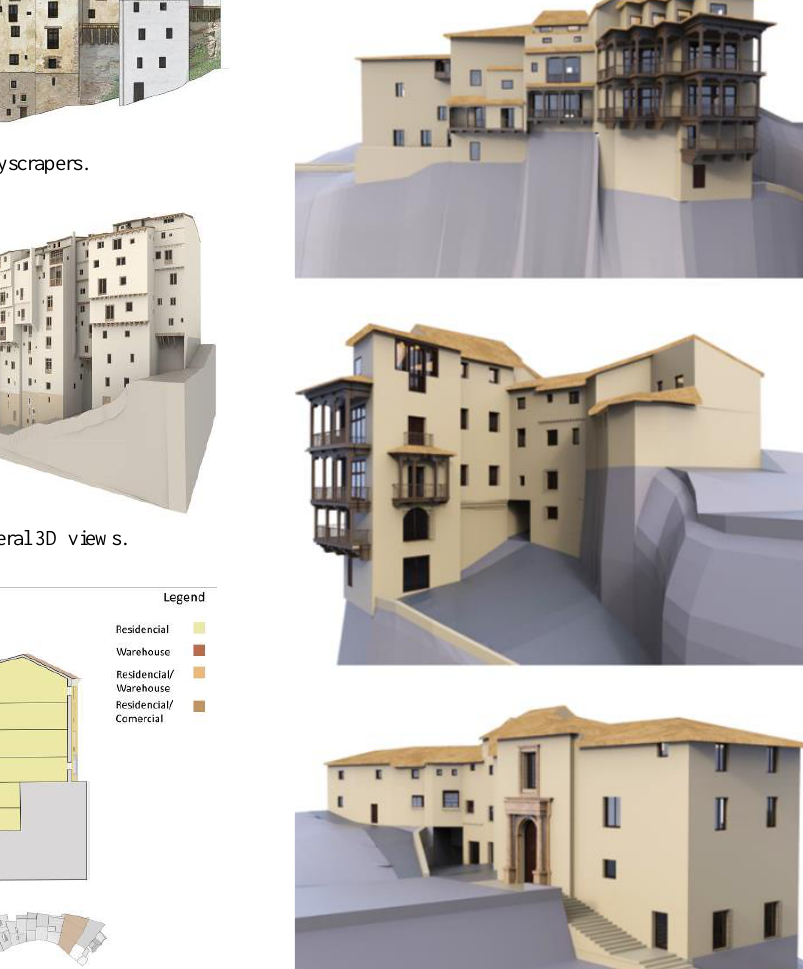
Figure 8. Analysis of typologies and functions. Figure 9. Hanging houses - general 3D